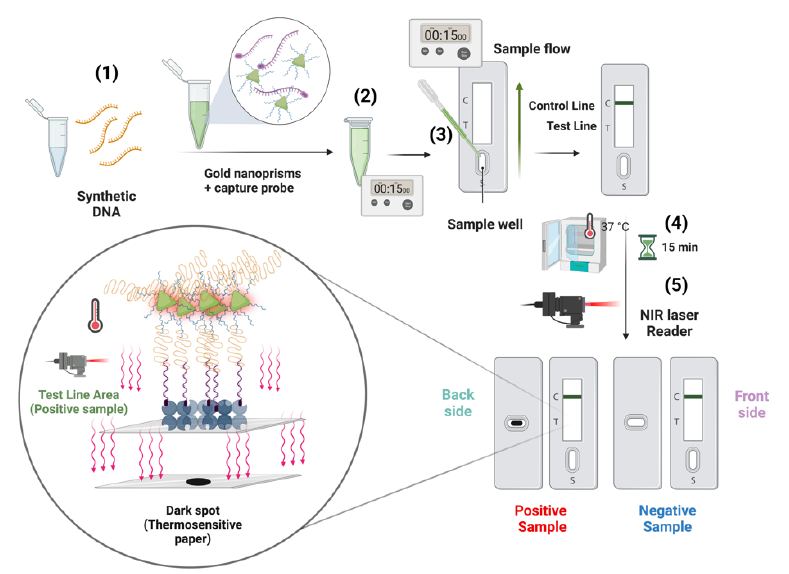
Figure 5. Scheme of the thermal lateral flow system and the analytical procedure. 1 — Sample addition to a solution containing gold nanoprisms and the capture oligonucleotide labeled with biotin;